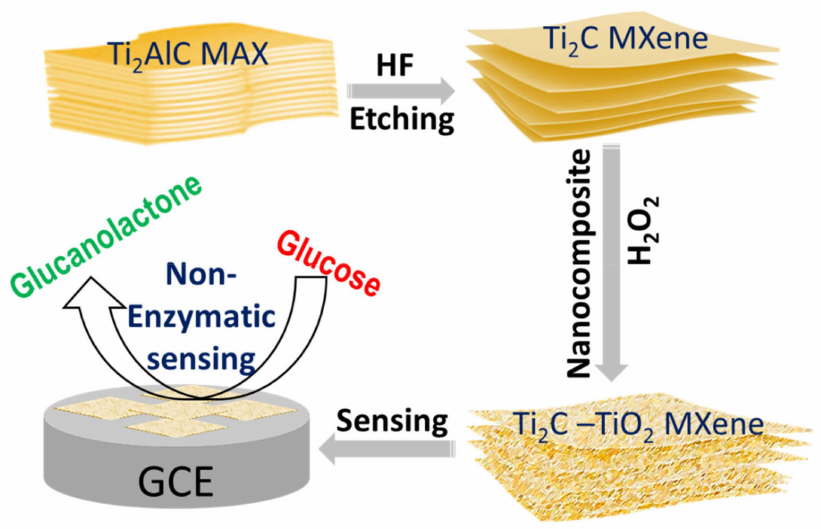
Figure 1. Scheme showing synthesis of Ti 2 C-TiO 2 MXene nanocomposite and its application in non-enzymatic glucose sensing